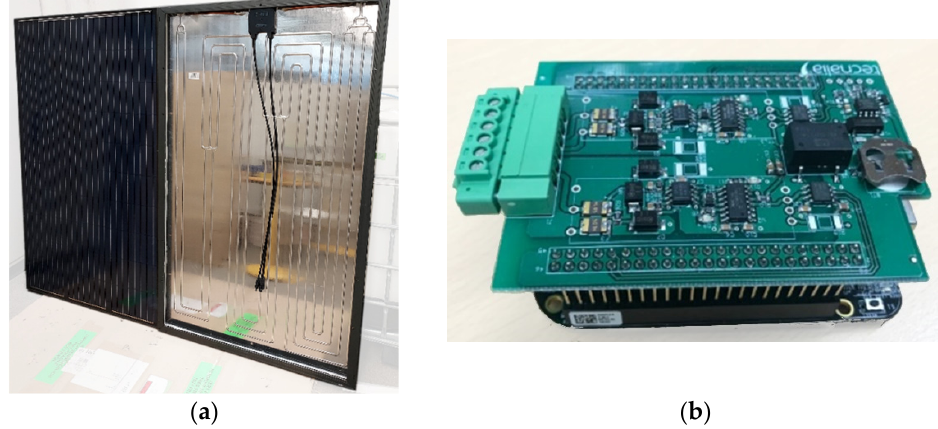
Figure 2. The innovations introduced in the PVT system under study: ( a ) The unglazed one-step manufactured PVT collector; ( b ) the overall control system implemented in a Beagle Bone Board.